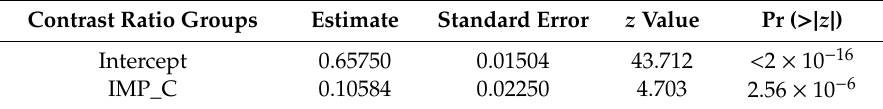
Table 7. Logistic regression analysis results of the contrast ratio groups.